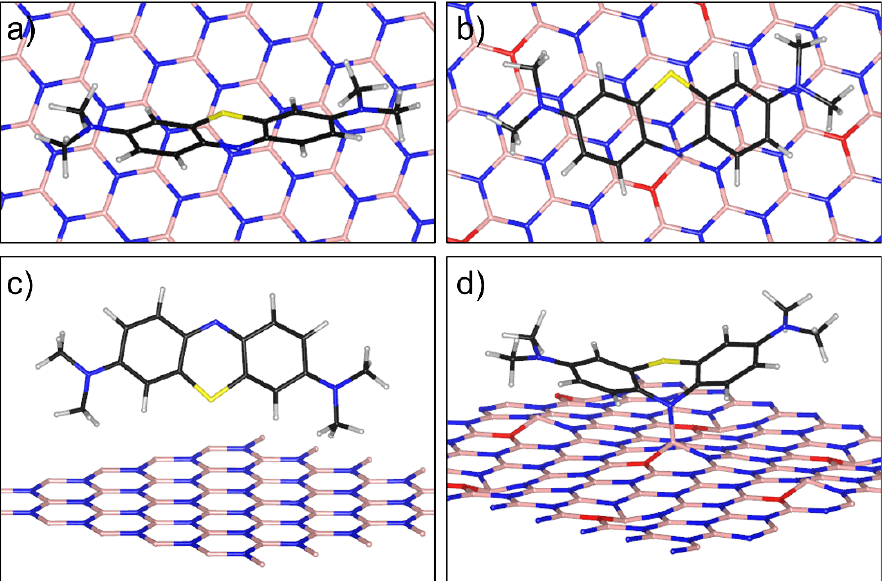
Figure 11. Methylene blue molecule adsorbed on the surface of pure ( a , c ) and oxidized BN ( b , d ), top ( a , b ) and side ( c , d ) view, respectively. Oxygen defects are marked in red and nitrogen in blue.